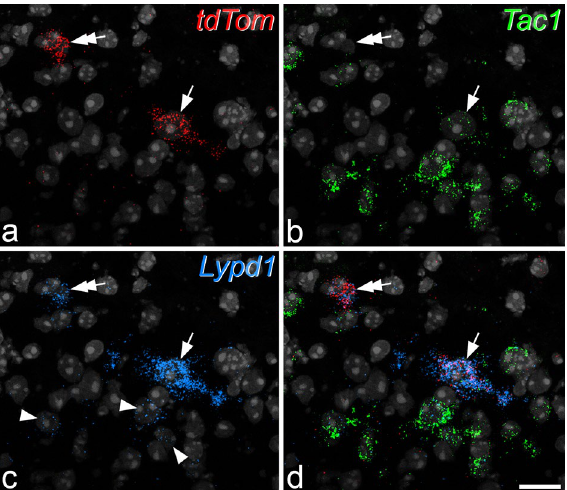
Figure 5. Fluorescence in situ hybridisation with RNAscope in a transverse section from a Phox2a::Cre;Rosa26 LSL-tdTomato mouse. The section has been reacted with probes directed against tdTom (red), Tac1 (green) and Lypd1 (blue) mRNAs. These are shown separately in ( a – c ), and combined in ( d ). The nuclear counterstain NucBlue is shown in grey. Two tdTom -positive cells are present in this field. One of these (arrow) is positive for Tac1 , while the other (double arrow) is not. Several smaller Tac1 -positive cells are present, and these are likely to be interneurons. Both of the tdTom -positive cells are also positive for Lypd1 . However, many other smaller cells show weak Lypd1 , and some of these are indicated with arrowheads. Images are projections of confocal optical sections (1 μm z-separation) through the full thickness of the section. Scale = 20